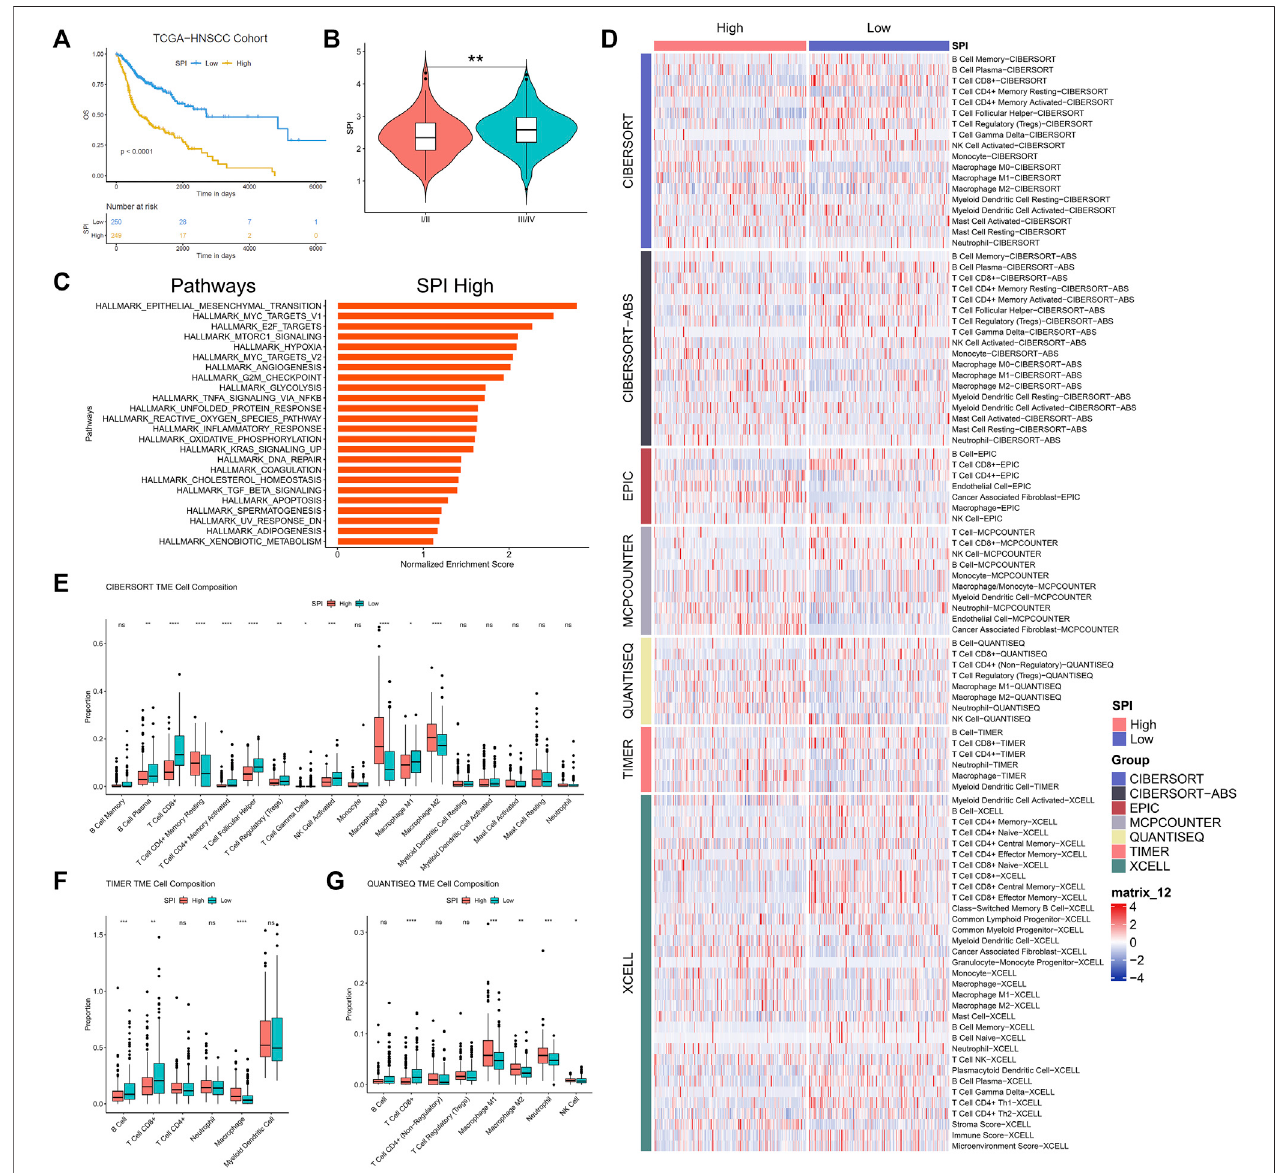
FIGURE 6 | (A) Kaplan-Meier curves of stemness prognostic index (SPI) in HNSCC. (B) Correlation between stemness prognostic index (SPI) and TNM stage of HNSCC. (C) GSEA for expression pro fi les in high SPI group over low SPI group. (D) Heatmap for immune cell in fi ltration landscape based on the CIBERSORT, CIBERSORT-ABS, QUANTISEQ, XCELL, MCP-counter, EPIC, and TIMER algorithms among high and low SPI group. Box plot showed the different proportions of tumor-in fi ltrating cells between different SPI groups based on CIBERSORT (E) , TIMER (F) , and QUANTISEQ (G) . p value < 0.05 was